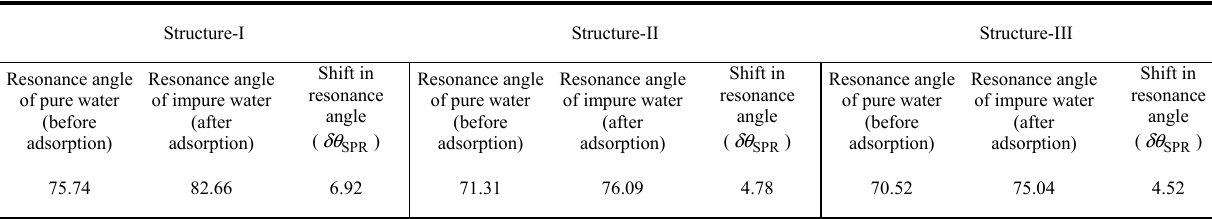
Table 2 Comparison table for the change in the resonance angle for structure-I, structure-II, and structure-III. Structure-I Structure-II